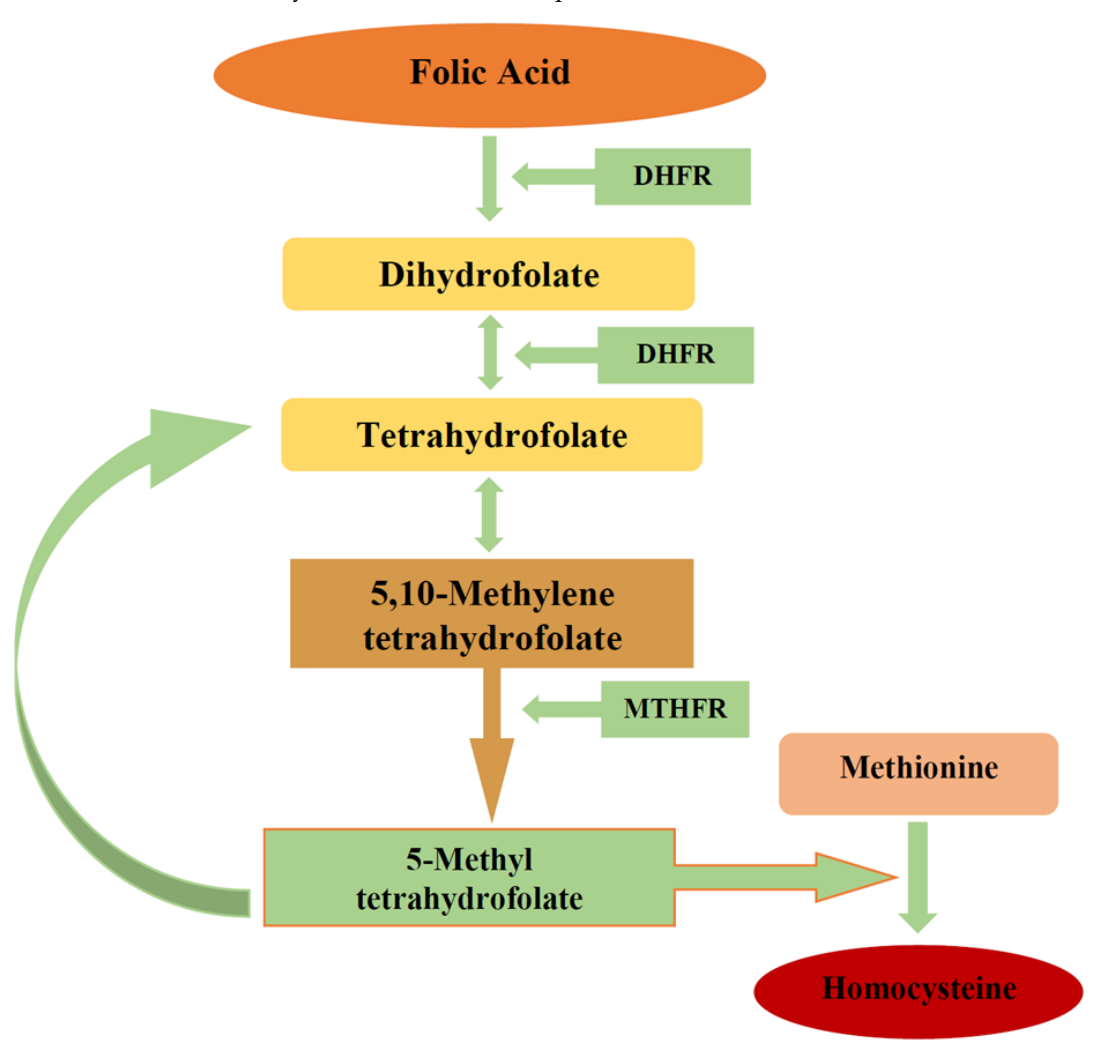
Figure 1. Folic acid metabolism. Figure legend: DHFR—dihydrofolate reductase; MTHFR—methy- lenetetrahydrofolate reductase.